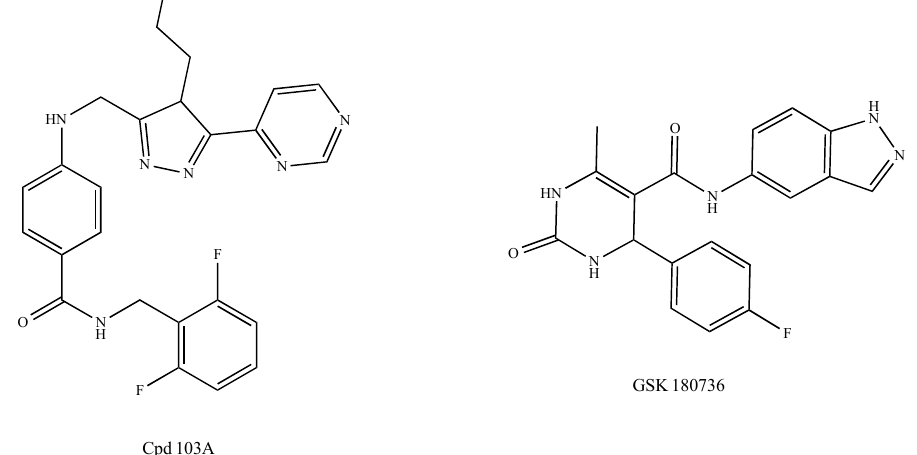
Figure 6. Structure of the GRK2 inhibitors 103A and GSK180736.